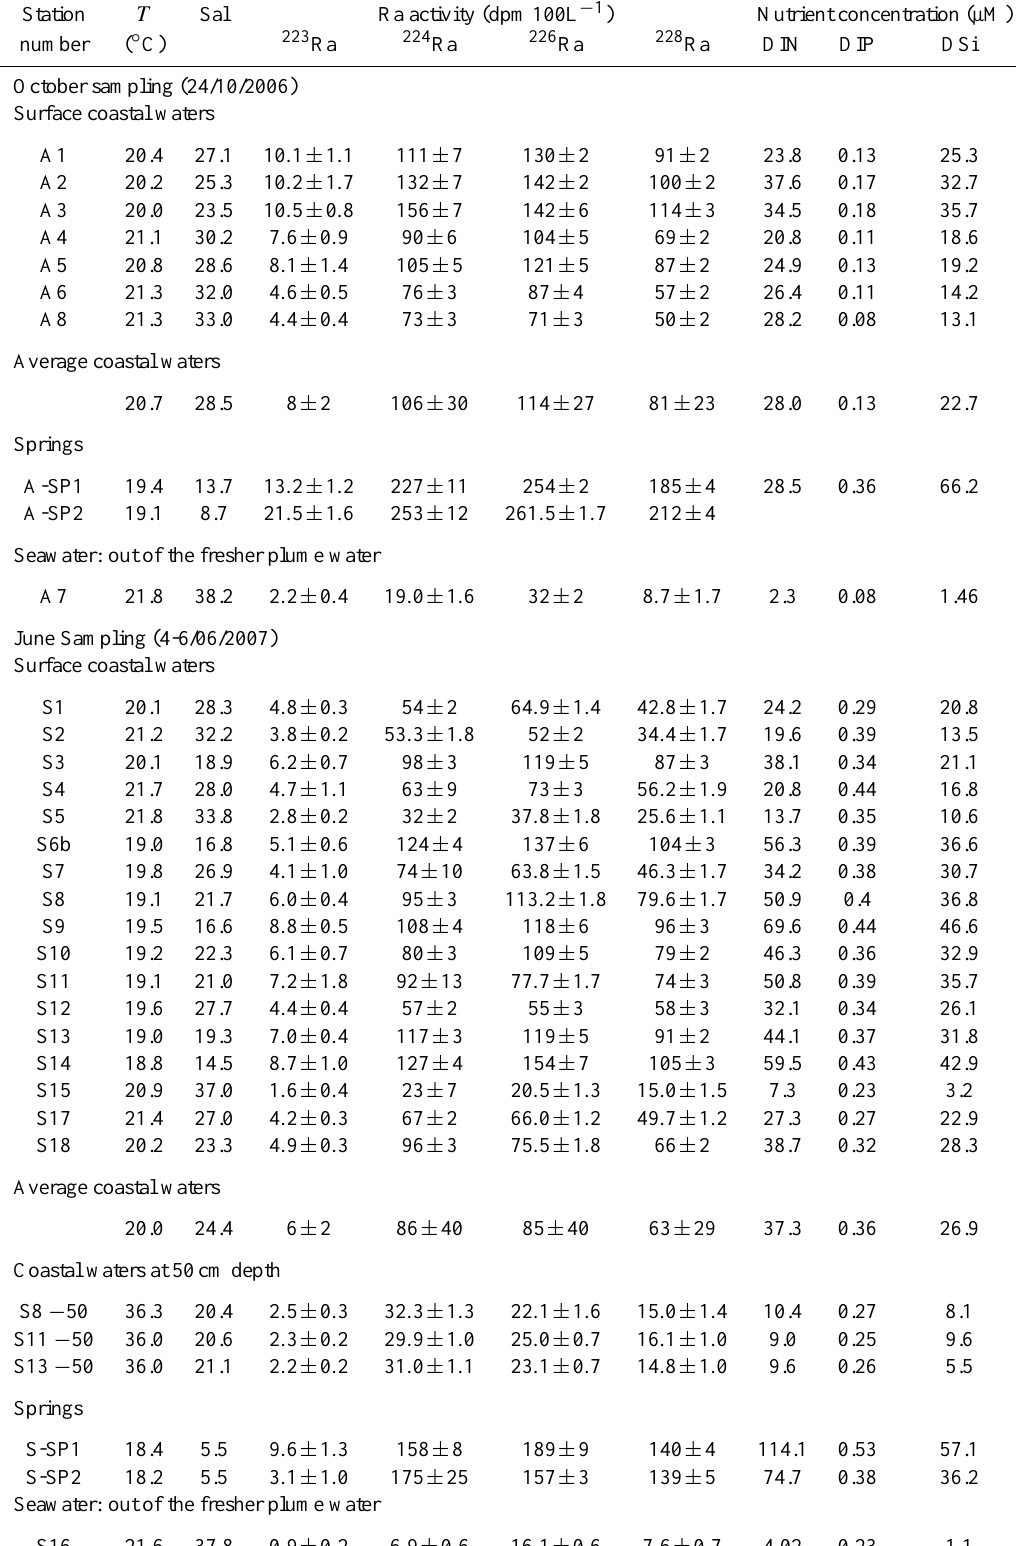
Table 1. Temperature, salinity, radium activities and nutrient concentrations for all the stations samples in October 2006 and June 2007.